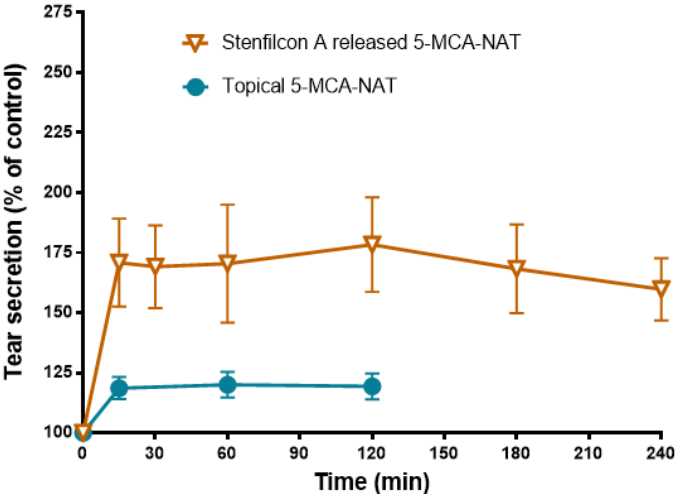
Figure 8. The effect of 5-MCA-NAT released from CLs and administered topically in tear secretion. Stenfilcon A lenses were preloaded with 5-MCA-NAT 250 µ M for 12 h and 10 µ L of 5-MCA-NAT 250 µ M was administered topically on the rabbit eyes. Tear secretion was evaluated over 240 min (for CLs experiments) and over 180 min (for topical experiments) versus the basal tear secretion and tear secretion after the topical application of a saline solution containing 1% DMSO, respectively (100% tear secretion). The tear secretion values (%) are presented as mean ± S.E.M. of n = 12 lenses and n = 24 rabbit eyes.